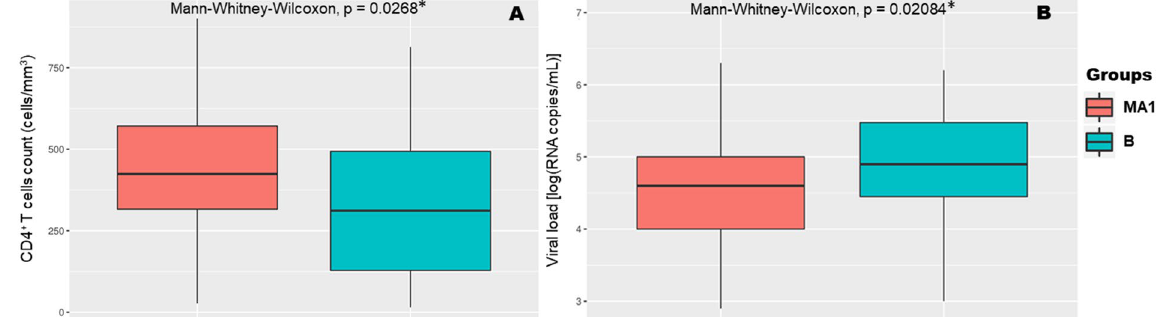
Figure 4. Comparison of infection progression outcomes between the MA1 study group and the control group (B subtype). There were statistically significant differences between the two study groups regarding CD4 + T-cell counts ( A ) and viral load ( B ). * At a significance level of 0.05 using the Mann-Whitney-Wilcoxon Test (p <